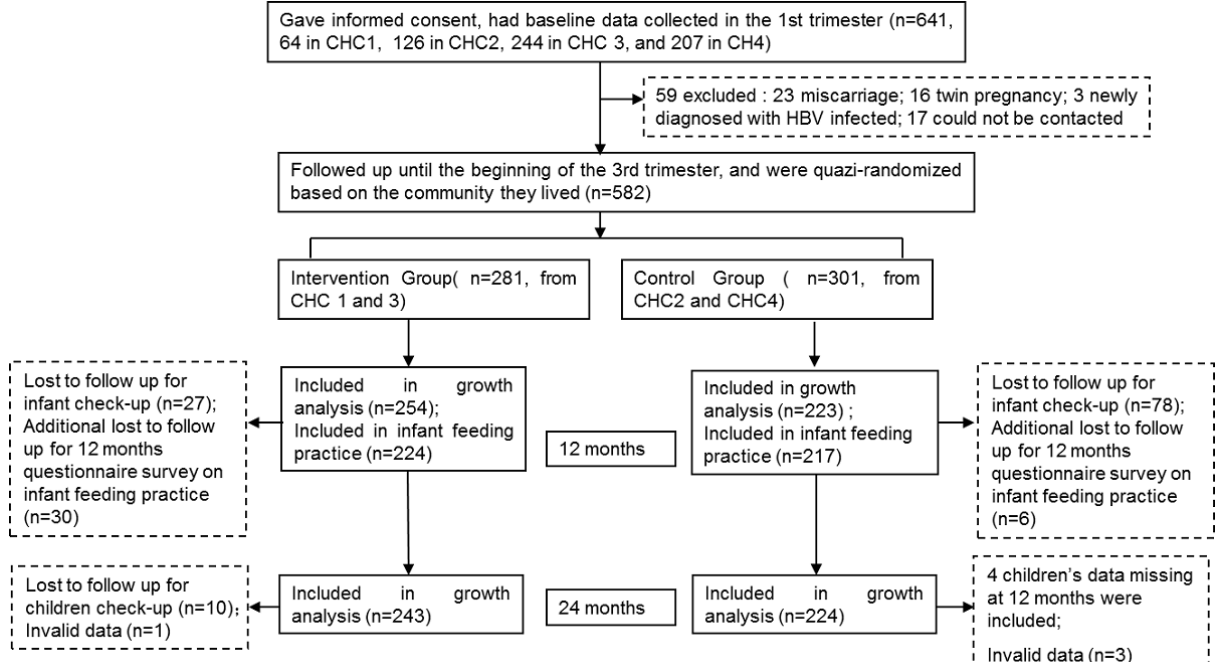
Figure 1. Participant recruitment and retention. CHC: community health center; BMI: body mass index; HBV:hepatitis b